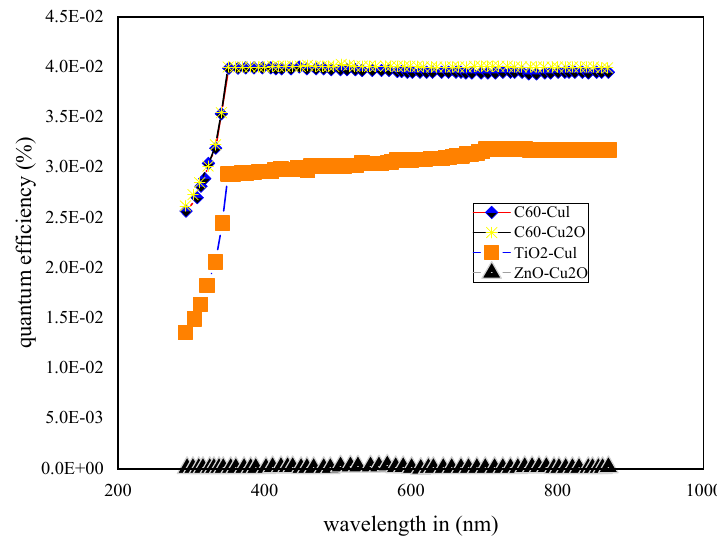
Figure 4. Current density for different structures.